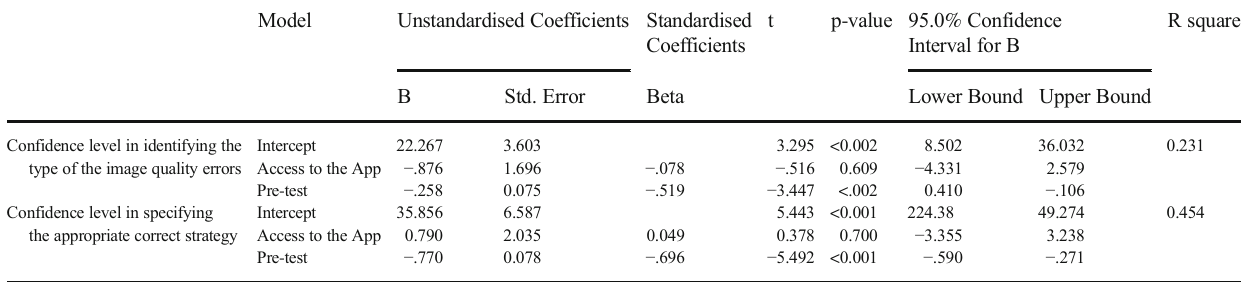
A table demonstrating a multiple linear regression used to evaluate the impact of the app on radiographers ’ level of confidence in reviewing MR image